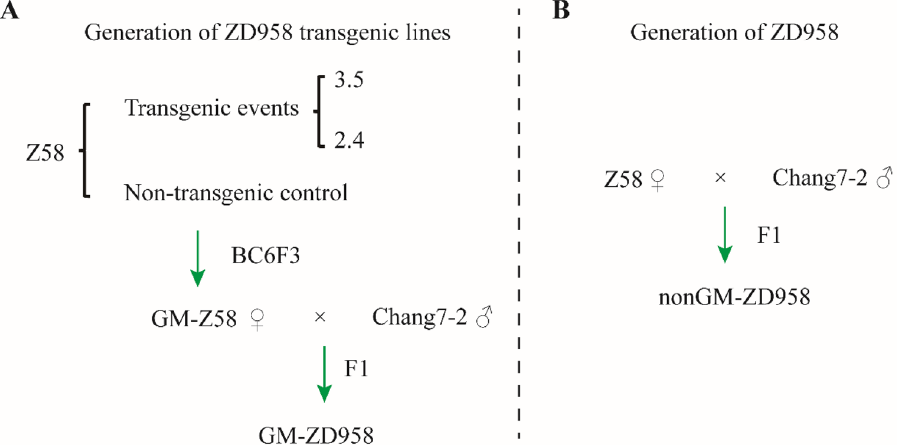
Figure 1. Pipeline of transgenic maize lines in this study. ( A ) The transgenic Zhengdan958 (GM-ZD958) was produced by agrobacteria-mediated transformation into Zheng58 (Z58) and then was used to hybrid with